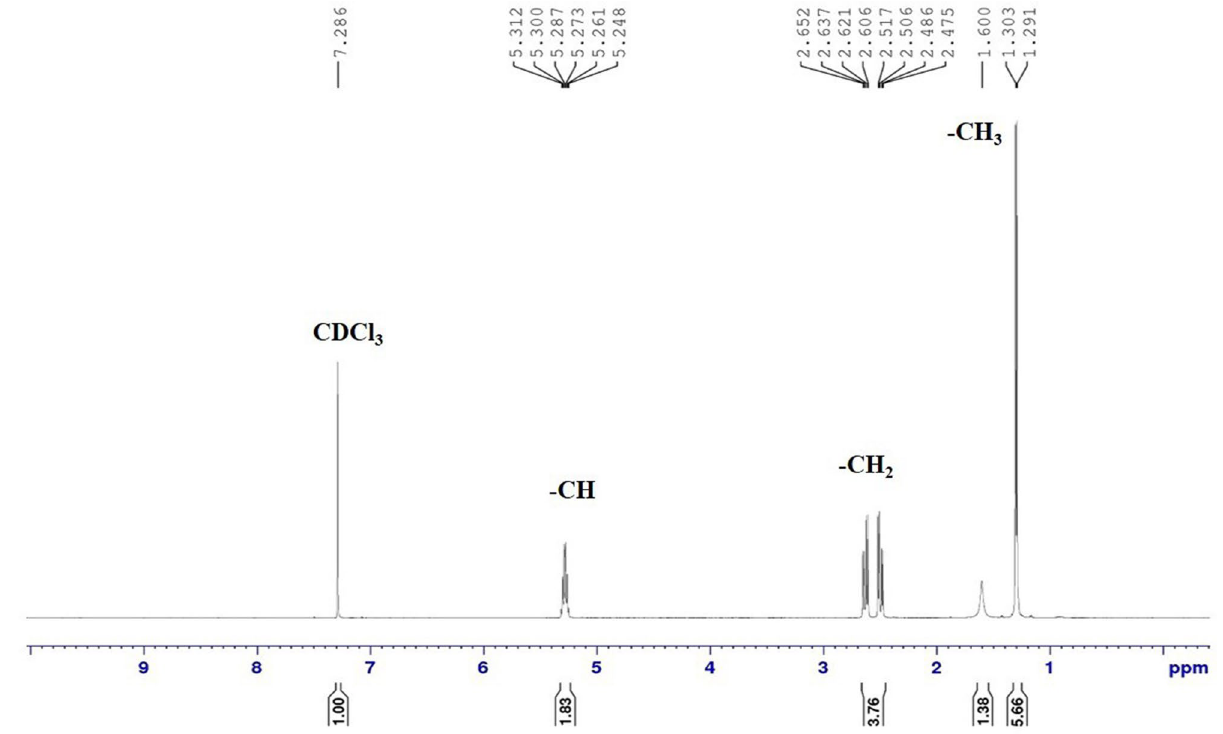
Figure 5. Proton Nuclear Magnetic Resonance Spectroscopy ( 1 H NMR) spectrum of PHB produced by Rhodococcus pyridinivorans